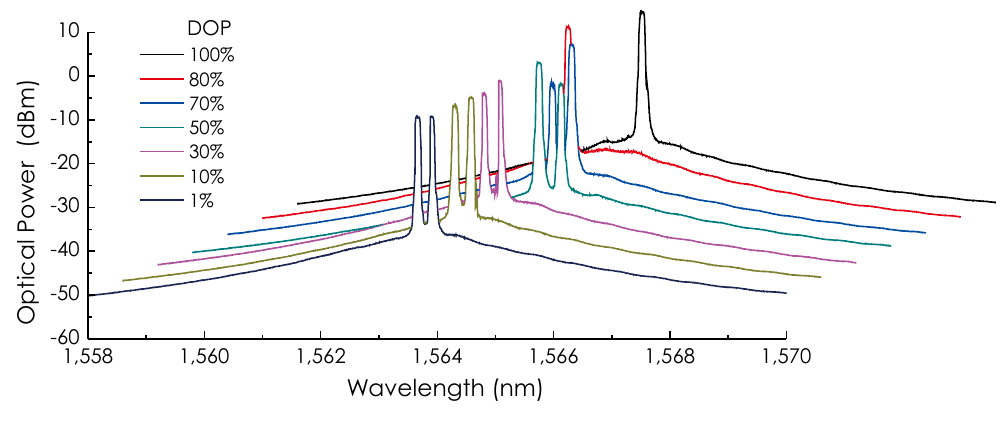
Figure 6. Output spectra of the chaotic fiber ring laser at different DOP values.